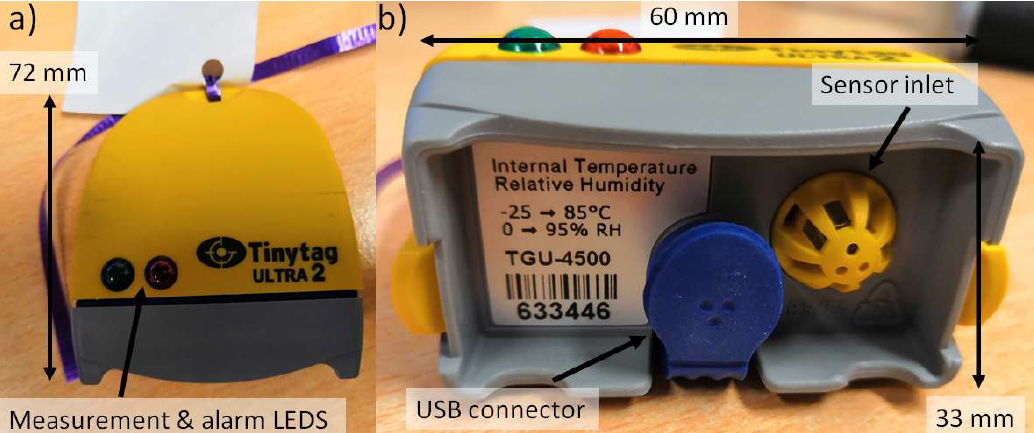
Figure 3. Images of the Tinytag sensors deployed (a) plan view and (b) closeup of the sensor base where the inlet is visible. All sensors had a piece of paper attached describing what they were measuring and who to contact if issues arose.